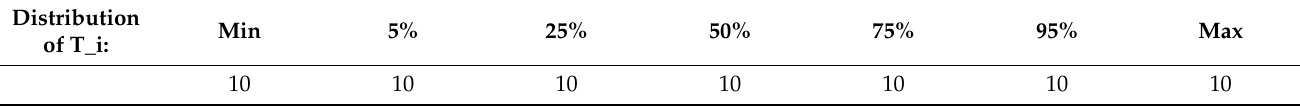
Table 3. Distribution of